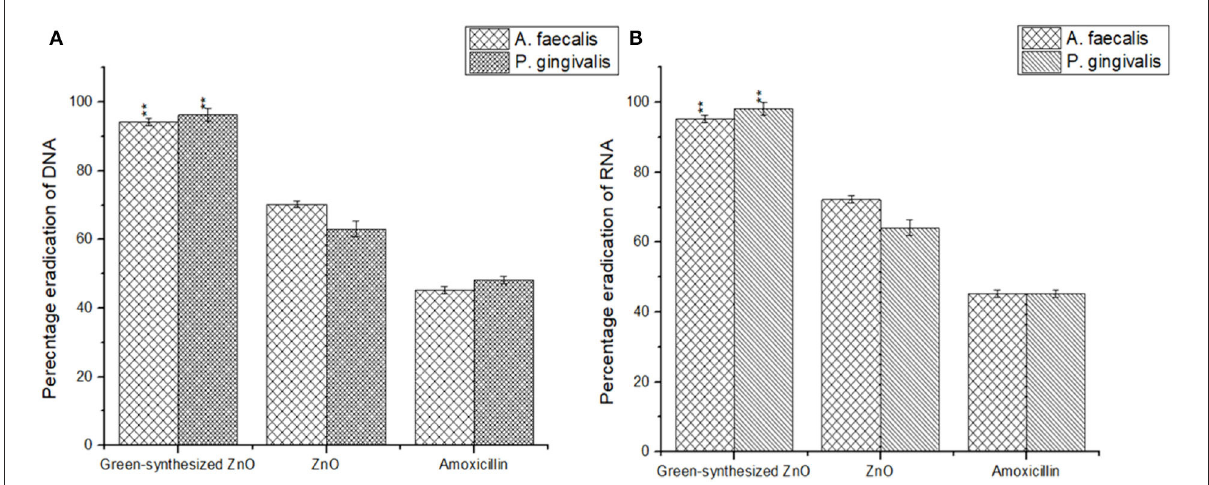
FIGURE8 Biogenic ZnO NPs were responsible for a marked reduction in the DNA (A) and RNA (B) content of the sessile microbial colonies of A. faecalis and P. gingivalis .